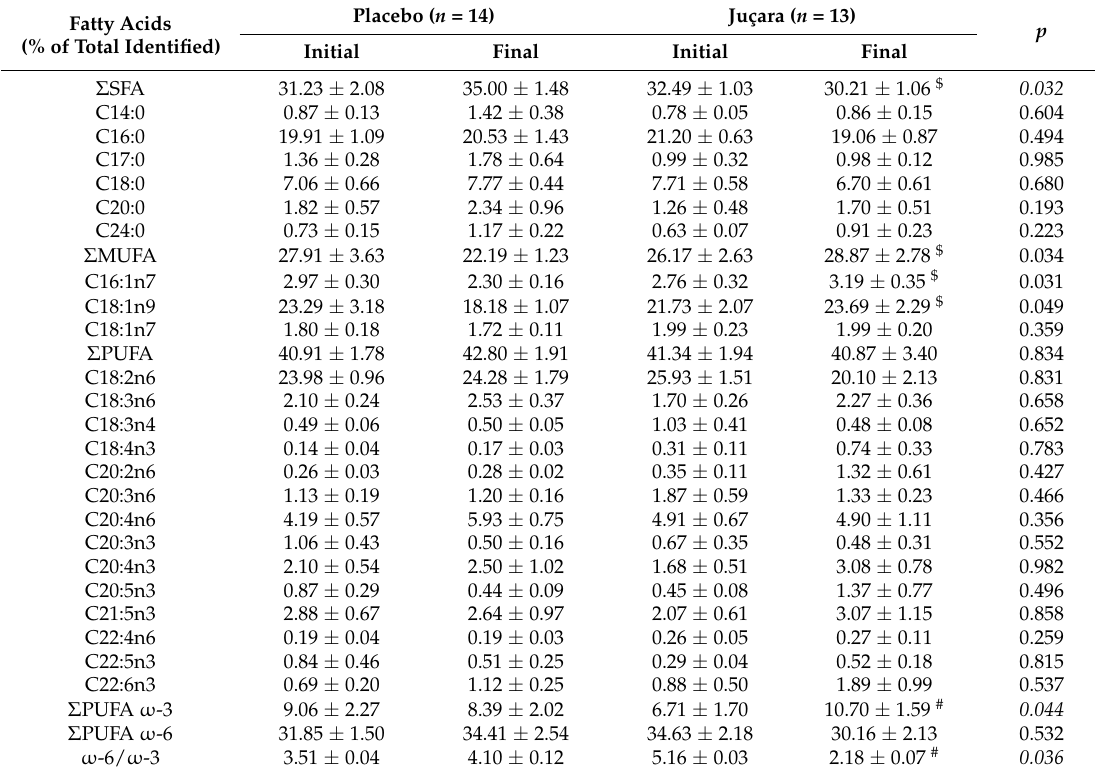
Serum fatty acids profile before and after supplementation for 6 weeks between experimental